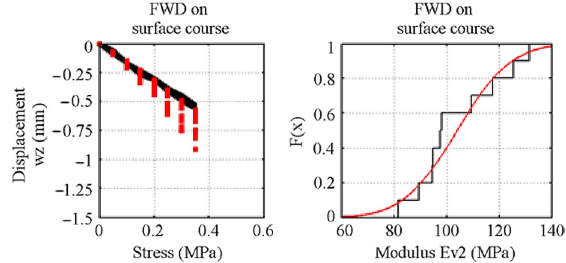
Fig. 12. Example of deformation curve plotted for improved subgrade course (compared against several sample curves based on in-situ SPB test) including cumulative distribution function for values of the modulus of deformation (discrete and